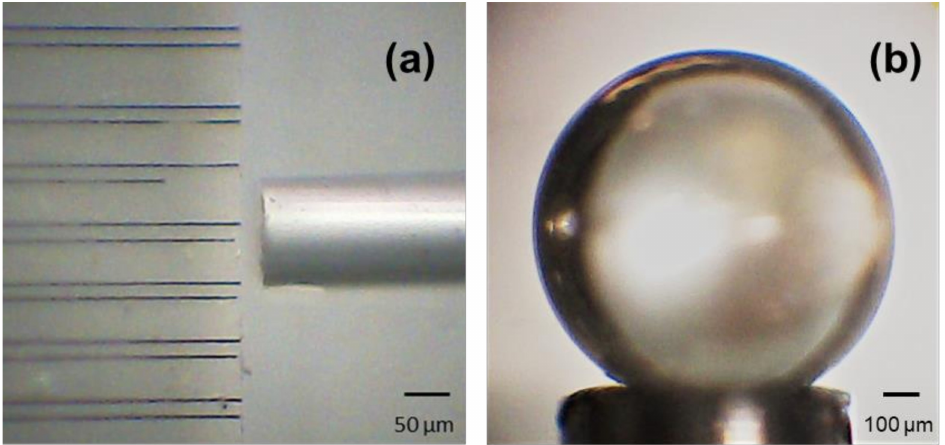
Figure 2. ( a ) Single mode bare fiber butt-coupling to a Type II diamond waveguide. ( b ) The 1 mm diameter diamond microsphere being held by a needle tip and a suction